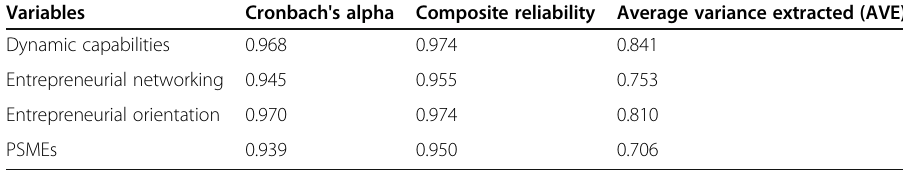
Table 2 Construct reliability and